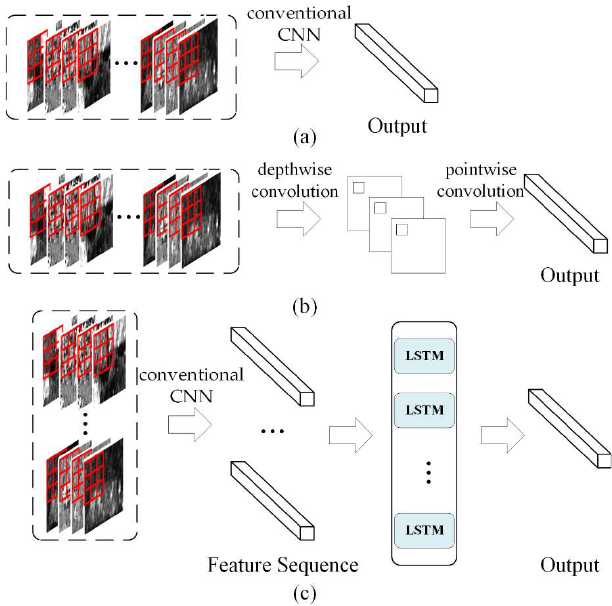
Figure 6. Classification of ( a ) Net A, ( b ) Net B, and ( c ) Net C.